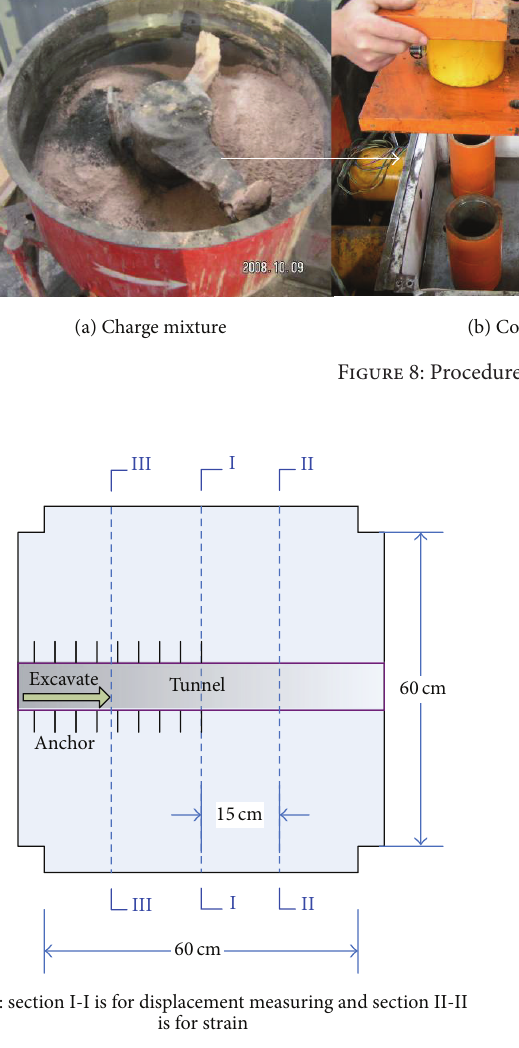
Figure 9: Layout sketch of monitoring sections in the model. The model is divided to two parts: anchored area and the area without anchoring. The measuring sections were set to 3, which divides the model to 4 parts evenly. The II measuring section was chosen to be the middle part of the model, while the I and III sections are quarter and three-quarters of the model. Then, the measuring section can be used to monitor the deformation inside the model.